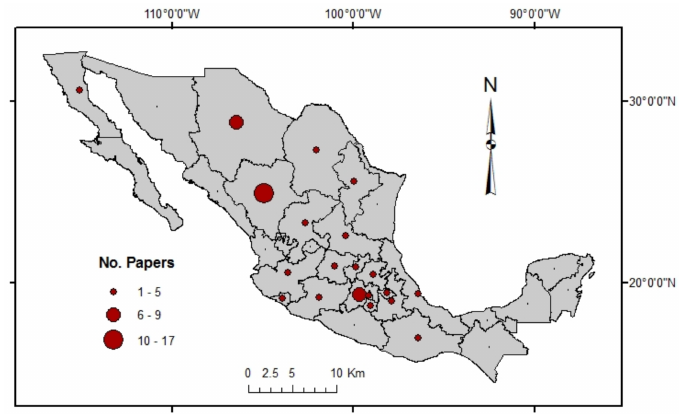
Figure 5. Dendrochronological studies performed in Mexico and grouped by